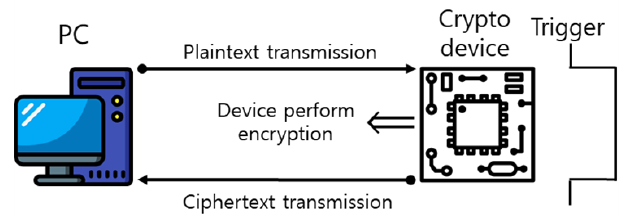
Figure 3. Protocol between PC and crypto device.